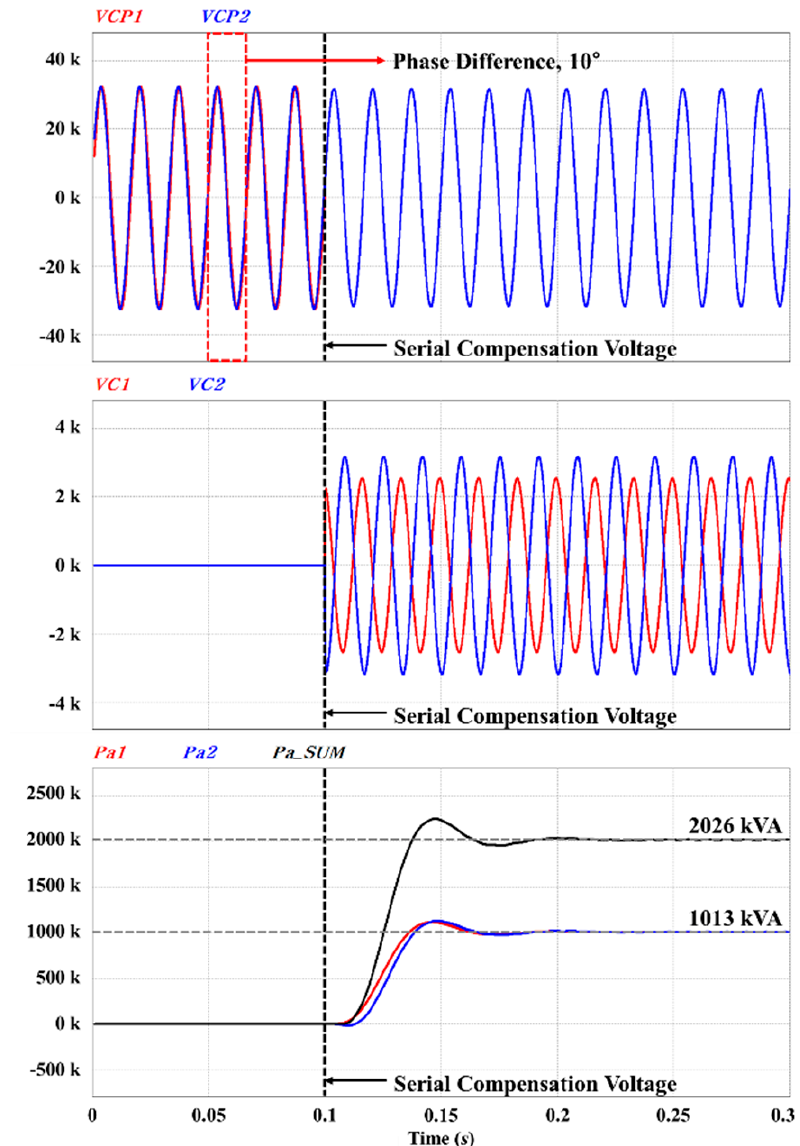
Figure 14. Connection point voltage and APC capacity at the controlled angle of 4.42°.